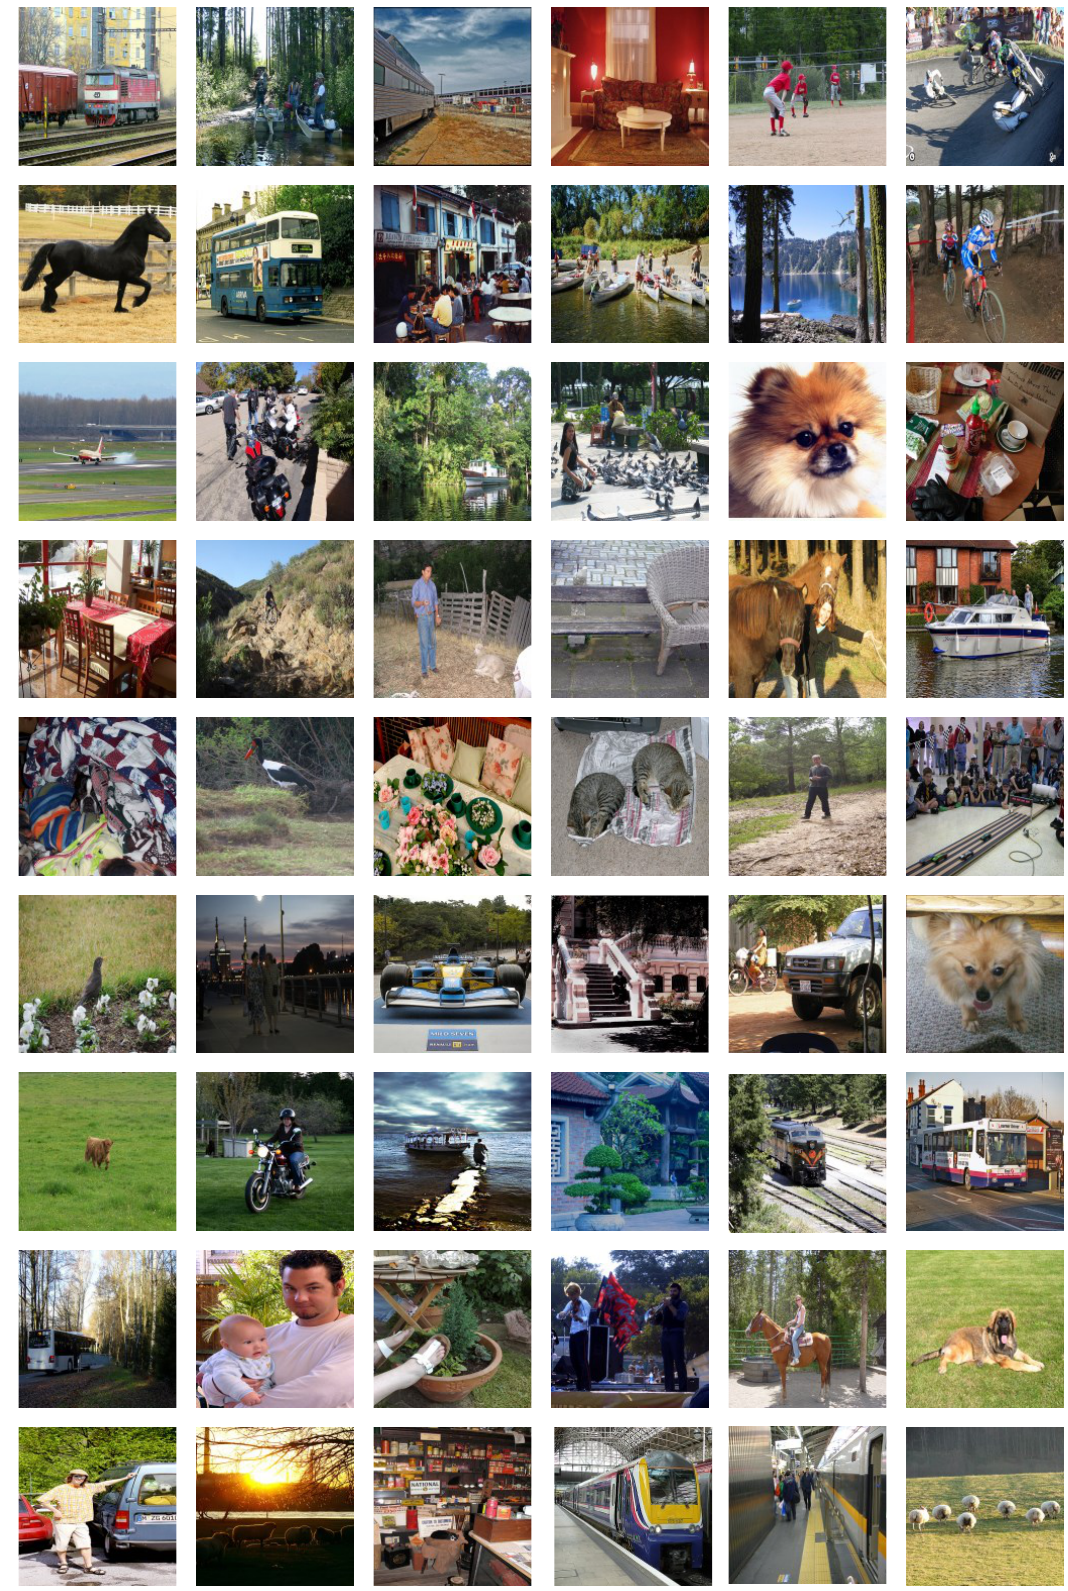
Figure 7. LR images from